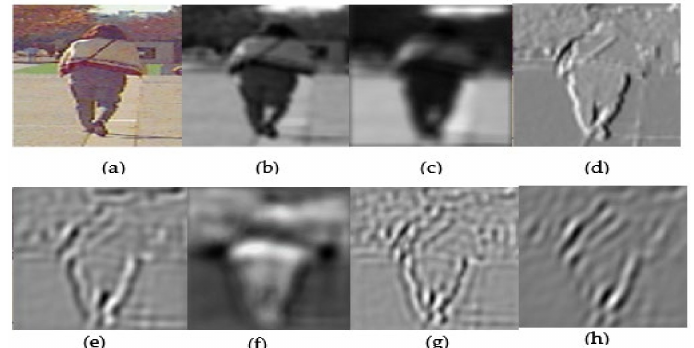
Figure 3. 4-BSMAB best activation visualizations of an image at various convolutional layers: ( a ) original image; ( b ) C1_1; ( c ) C2_1; ( d ) C2_2; ( e ) C3_1; ( f ) C3_2; ( g ) C4_2; ( h ) C7_1.